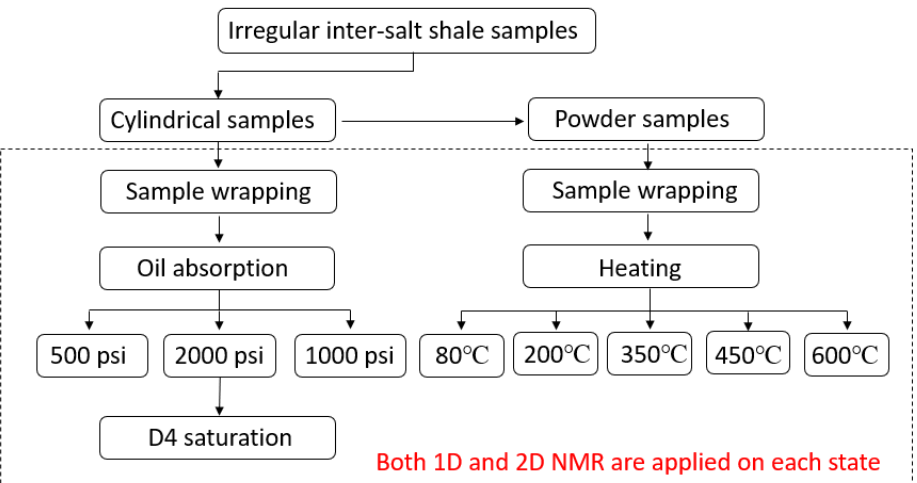
Figure 1. The flow chart of the experimental procedure. Experiment I: One-dimensional T 2 spectrum and 2D T 1 - T 2 spectrum NMR experi-